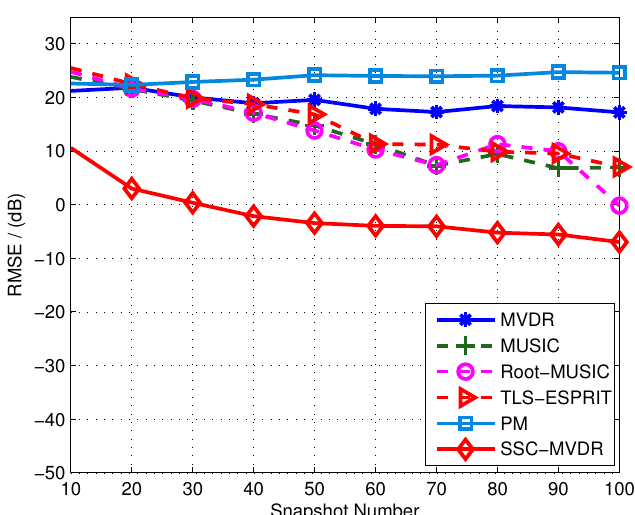
Figure 5. DOA estimation accuracy results obtained by the MVDR method, the MUSIC method, the Root-MUSIC method, the TLS-ESPRIT method, the PM method and the SSC-MVDR method when the acoustic source intensity is fixed at − 10 dB, and the number of snapshots is gradually increased from 10 to 100.